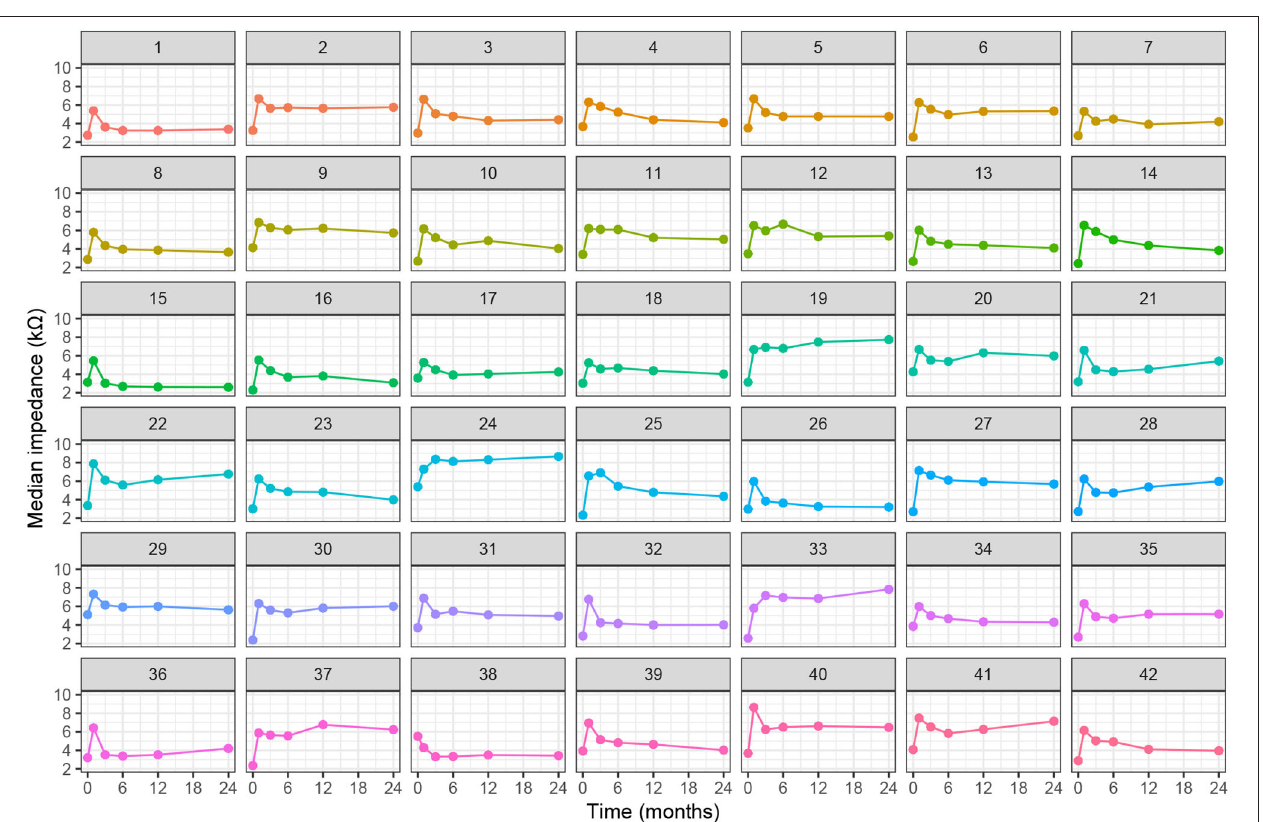
FIGURE 4 | Individual progression of clinical electrode impedances (median value of all electrodes) over time.